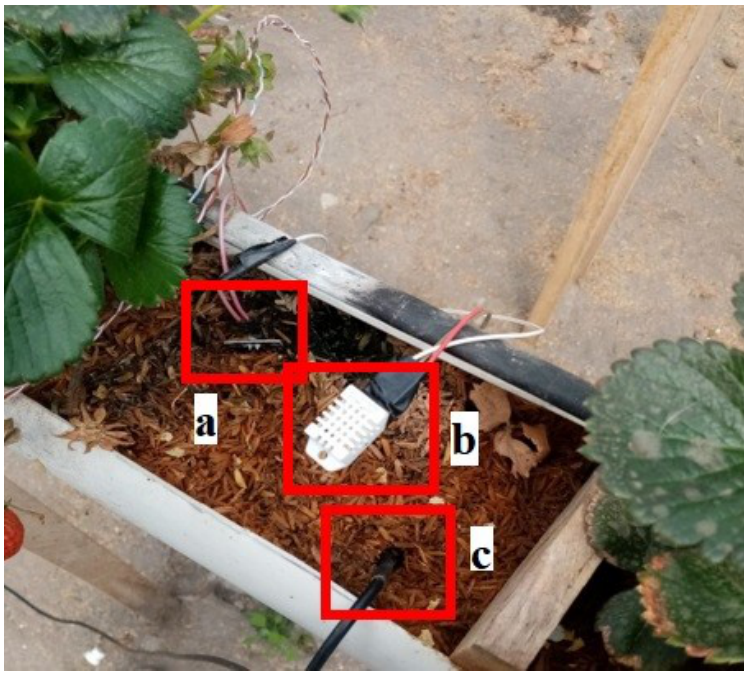
Figure 9. ( a ) Substrate humidity sensor, ( b ) dht22 sensor, ( c ) ds18b20 probe.